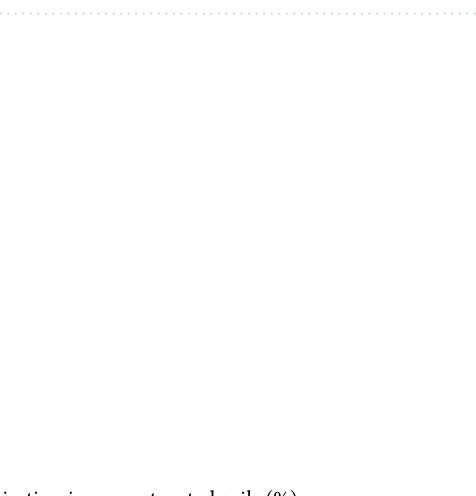
Figure 3. Autotrophic respiration rate of reconstructed soils and its relationship with heterotrophic respiration (mean ± standard error).